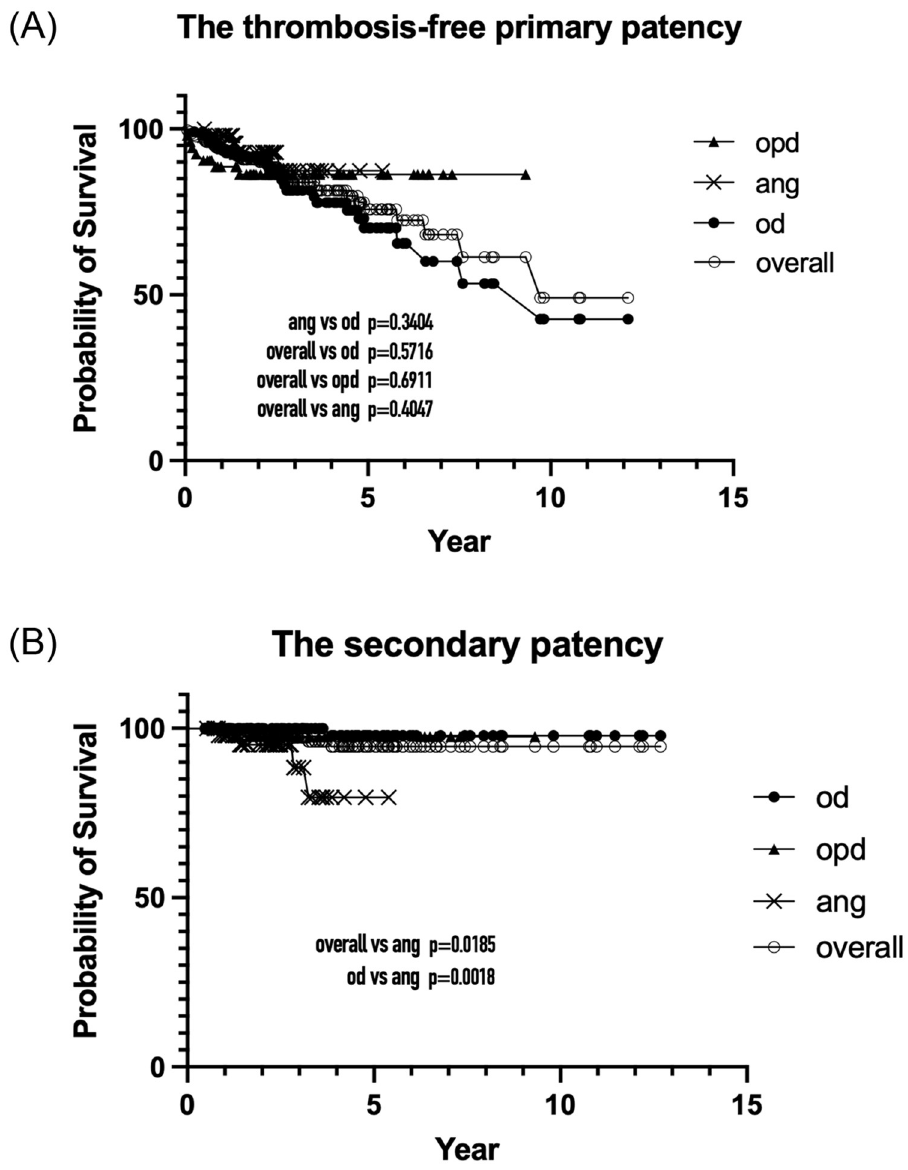
Fig 5. The Kaplan–Meier survival curves for the follow-up protocol and sub-protocols. (A) The thrombosis-free primary patency. No statistical differences were observed among the three follow-up sub-protocols. However, a declining trend was noticed for the curve of the od sub-protocol. (B) The secondary patency of the ang sub-protocol was statistically inferior to that of the od sub-protocol.